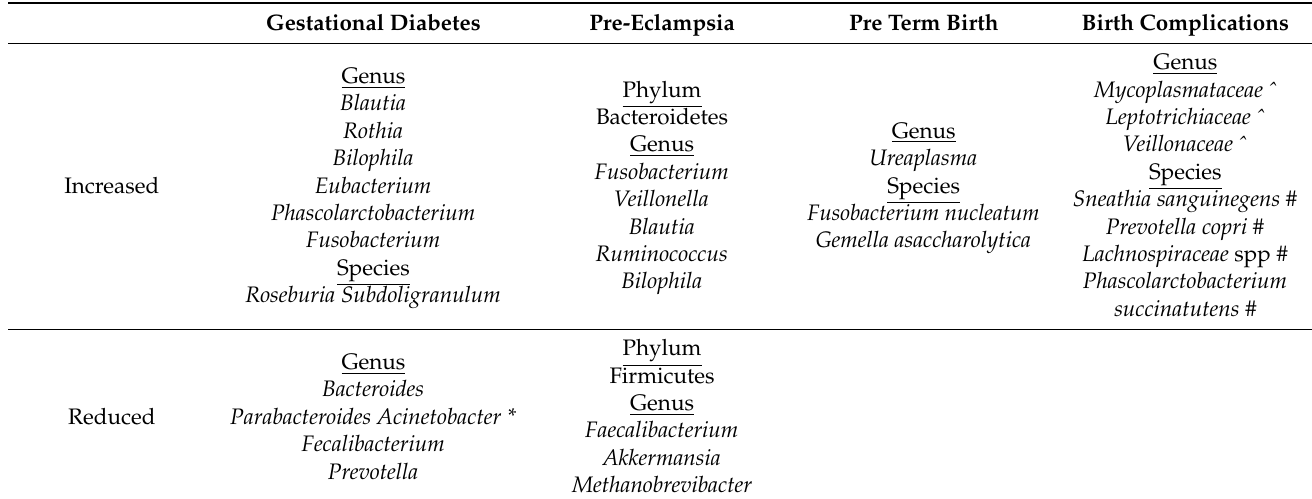
Table 1. Alterations of maternal gut microbiota in gestational